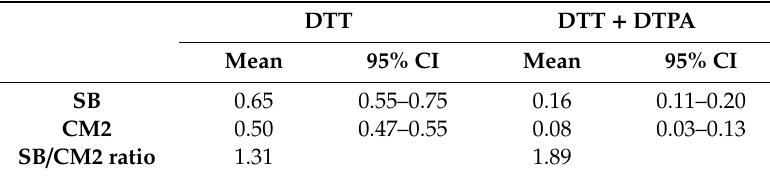
Table 2. Prooxidant content of SB and CM2 samples.